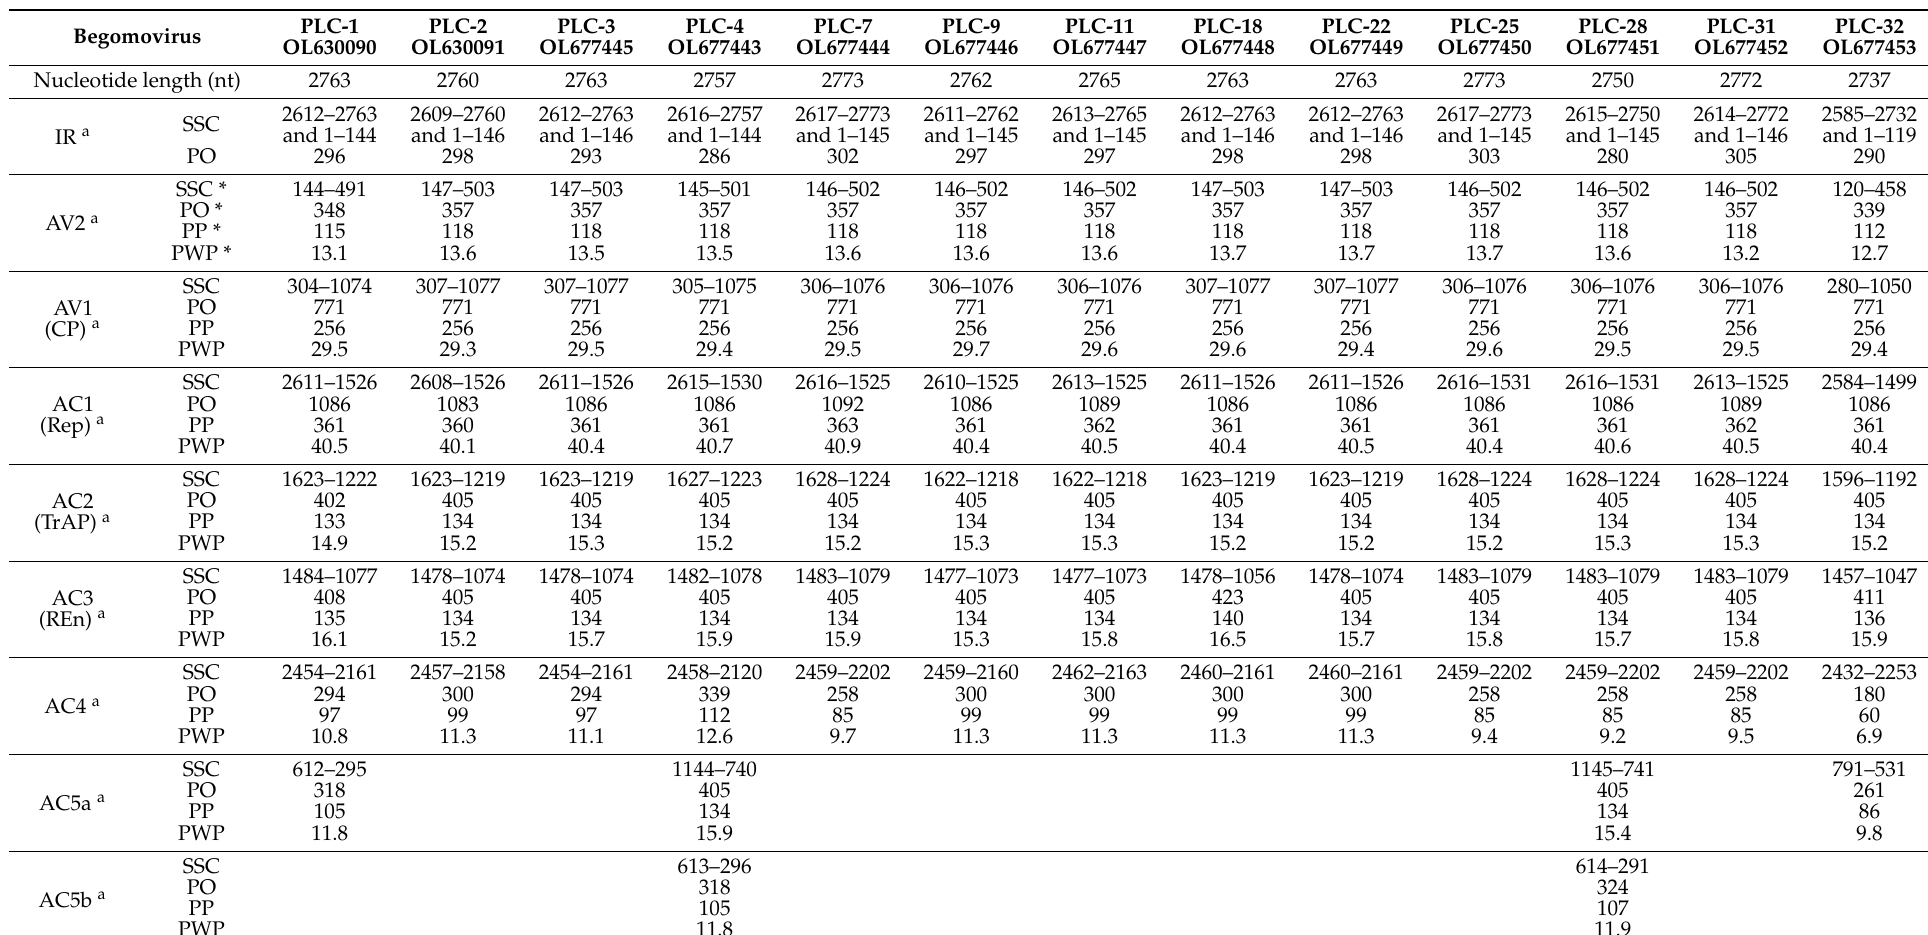
Table 1. Genome organization of DNA-A component of begomoviruses isolated from